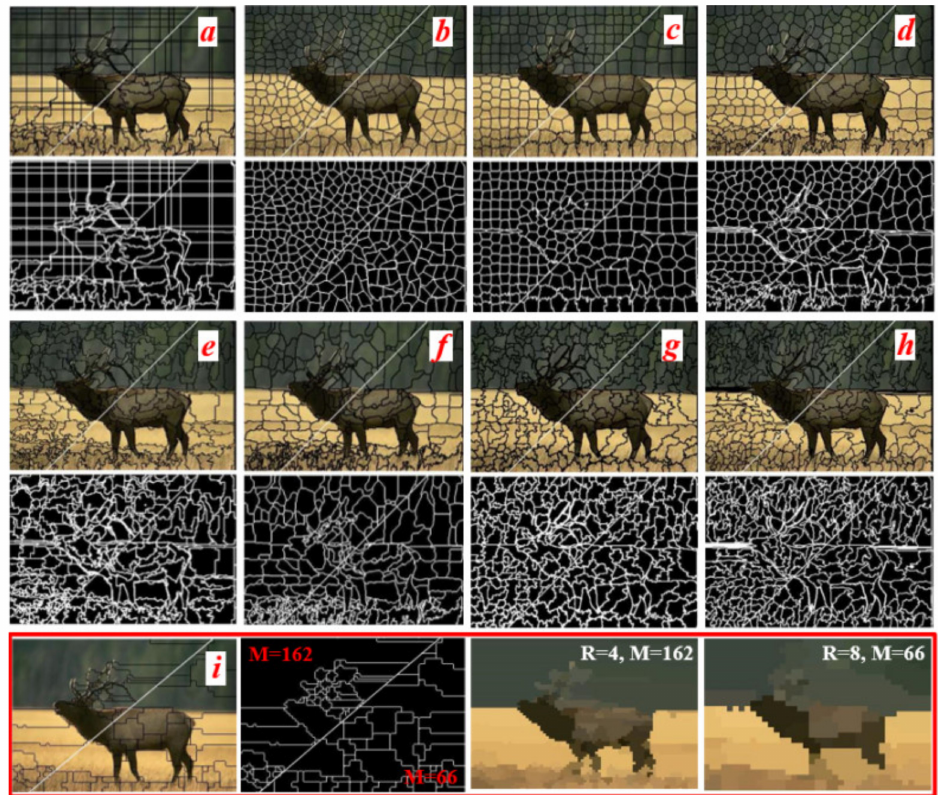
Figure 11. The segmentation results comparison of the different superpixel methods. ( a ) Lattice [17], ( b ) Ncuts [5], ( c ) SLIC [6], ( d ) LSC [8], ( e ) SEEDS [13], ( f ) EneOpt1 [18], ( g ) quick shift [19], ( h ) ERS [9], ( i )